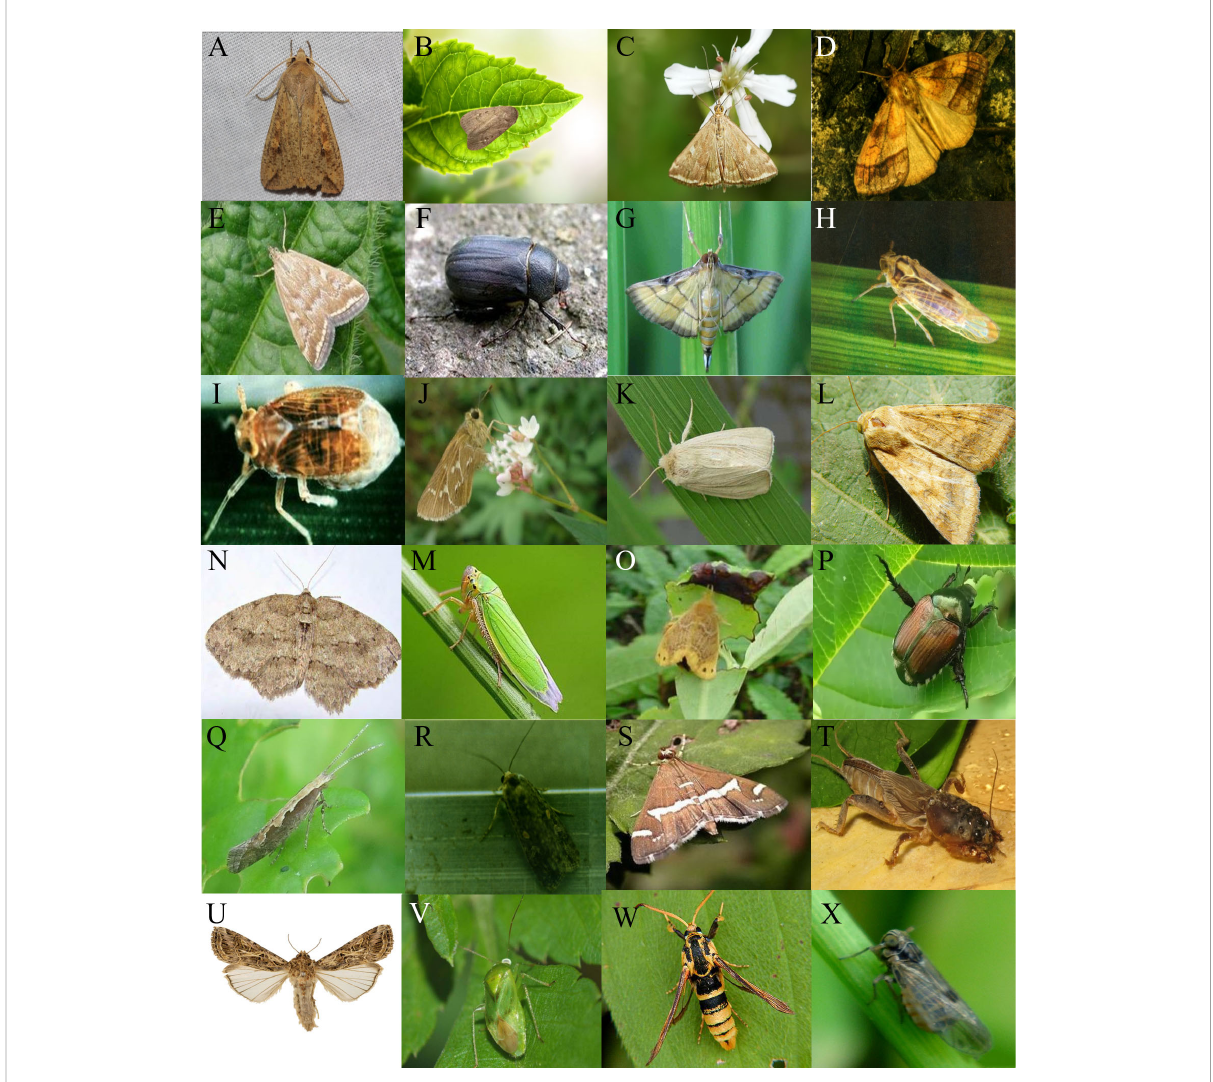
FIGURE 3 The pictures of pest species. (A) Mythimna Seperata, (B) Proxenus Lepigone, (C) Ostrinia Furnacalis, (D) Cifuna Locuples Walker, (E) Loxostege Sticticalis, (F) Holotrichia Perllela, (G) Cnaphalocrocis Medinalis, (H) Sogatella Furcifera, (I) Nilaparvata Lugens Stal, (J) Naranga Aenescens, (K) Chilo Suppressalis, (L) Helicoverpa Armigera, (N) Ectropis Obliqua Hypulina Wehrli, (M) Empoasca Pirisuga Matumura, (O) Euproctis Pseudoconspersa Strand, (P) Anomala Corpulenta Motschulsky, (Q) Plutella Xylostella, (R) Spodoptera Exigua, (S) Spoladea Recurvalis, (T) Gryllotalpa Orientalis Burmeister, (U) Spodoptera Litura, (V) Apolygus Lucorum, (W) Paranthrene Regalis Butler, (X) Laodelphax Striatellus (The pictures come from Image Database for Agricultural Diseases and Pests Research